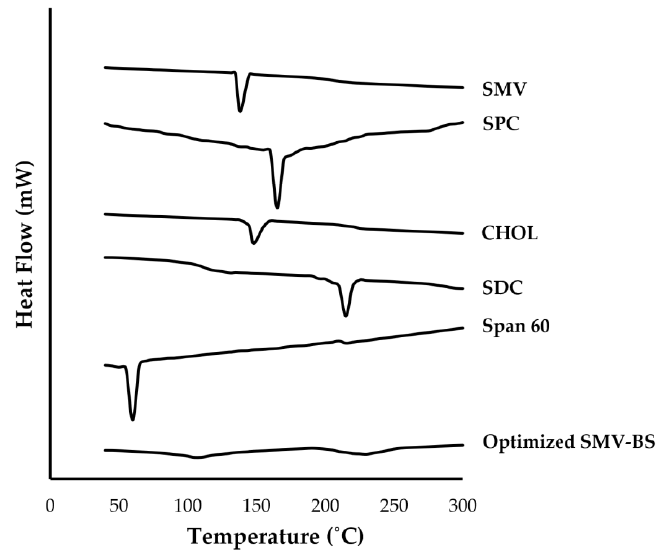
Figure 5. DSC thermograms of pure SMV, SPC, CHOL, SDC, Span 60 and optimized SMV-BS.